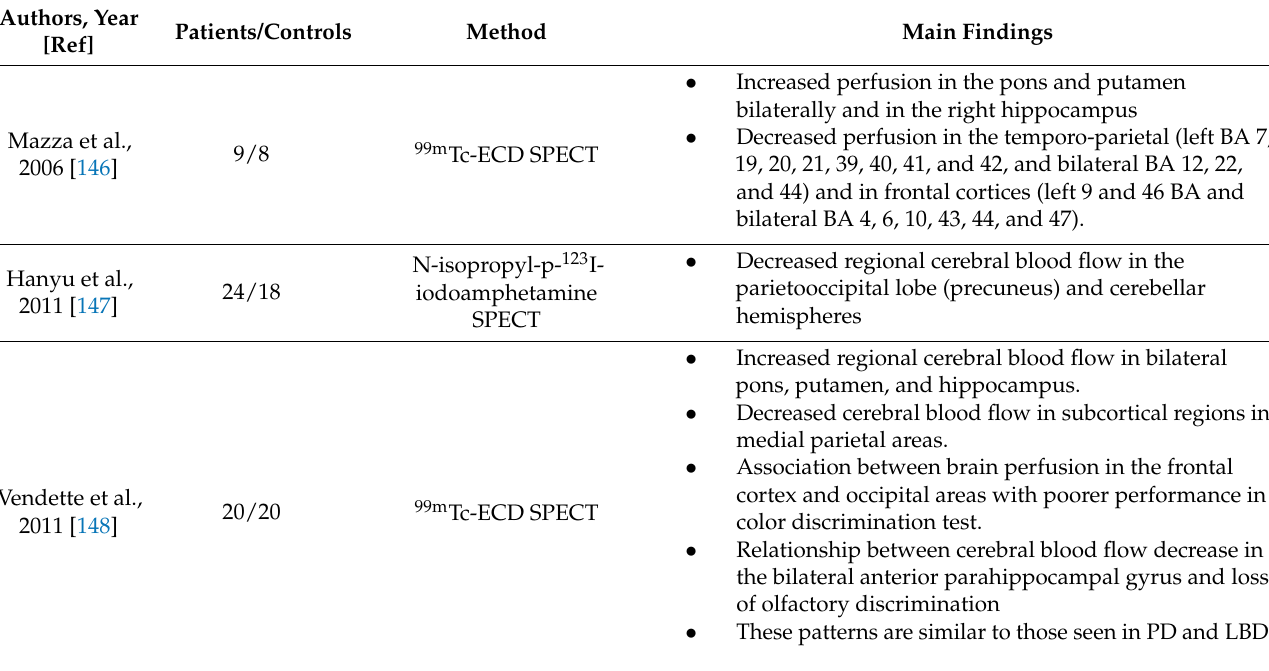
Table 2. Studies assessing cerebral blood flow/brain perfusion in patients with RBD. BA Brodmann areas; iRBD idiopathic RBD; LBD Lewy body dementia; MCI mild cognitive impairment; MRI magnetic resonance imaging; pASL Pseudocontinu- ous arterial spin-labeled; PD Parkinson’s disease; RBD REM sleep behavior disorder; 99m Tc-ECD SPECT: 99m Tc-Ethylene Cys- teinate Dimer single-photon emission computerized tomography; 99m Tc-HMPAO SPECT: 99m Tc-hexamethylpropyleneamine oxime single-photon emission computerized